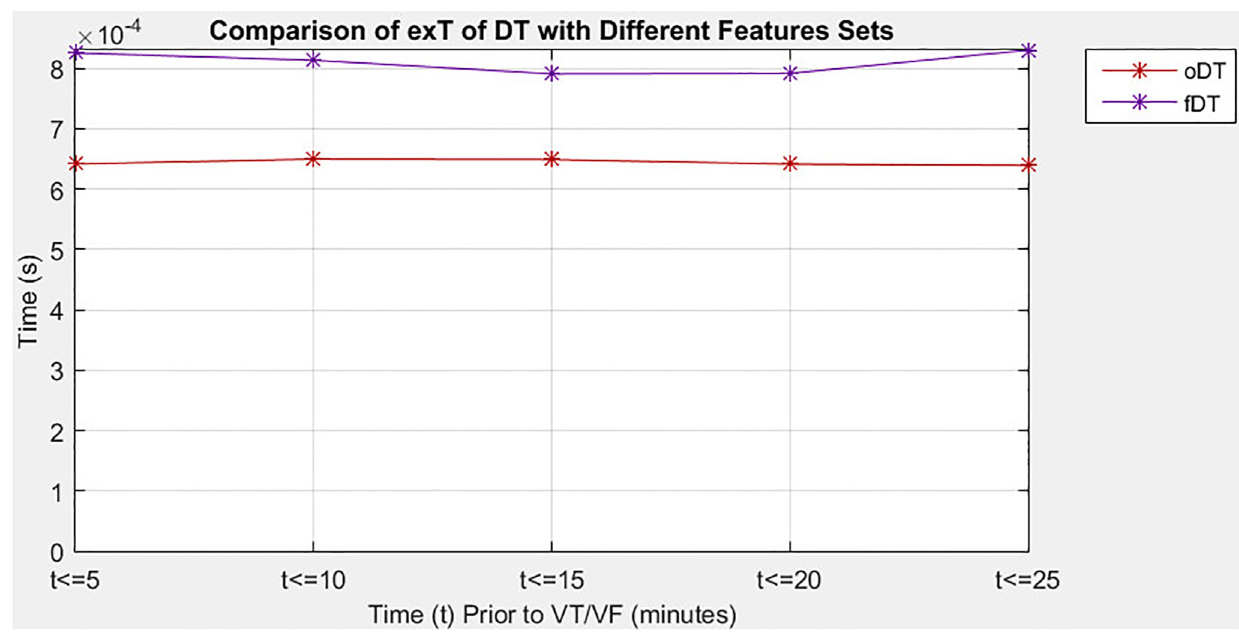
Fig 5. Comparison of exT for DT with different sizes of feature set.